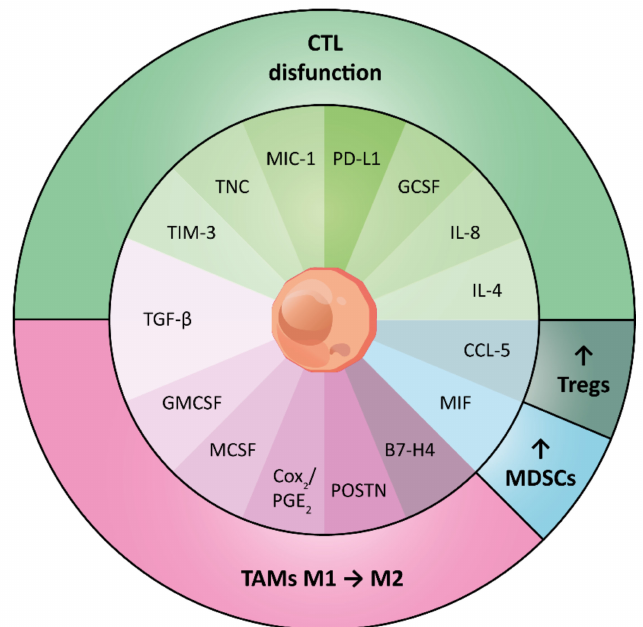
Figure 3. CSC immunomodulatory patterns impairing innate and adaptive immune system. A schematic model showing the plethora of cellular, molecular and physical factors either released from cancer stem cells (CSCs) within the tumor microenvironment (TME) or exposed by their surface that create an immune contexture crowded with immunosuppressive cells such as M2 tumor associ- ated macrophages (TAMs), myeloid derived suppressor cells (MDSCs) and T regulatory cells (Tregs) and impaired cytotoxic T lymphocytes